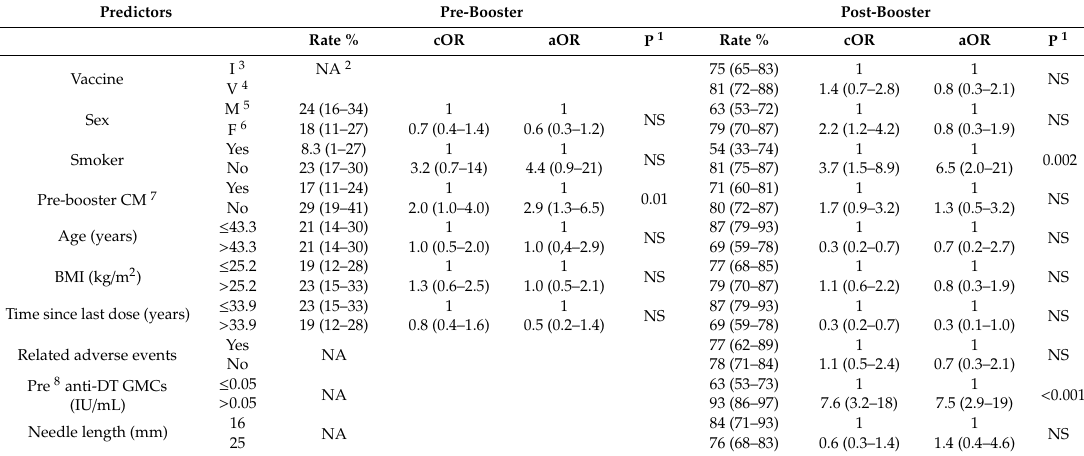
Table 3. Seroprotection rate with a threshold of 0.1 IU / mL pre- and post-booster immunisation against diphtheria, crude and mutually adjusted odds ratios (cORs, aORs) including the 95% confidence